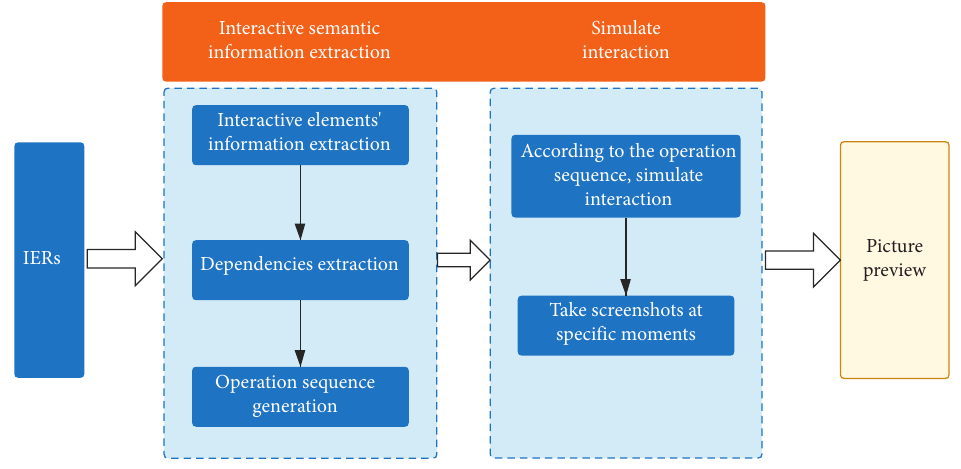
Figure 1: Overall flow